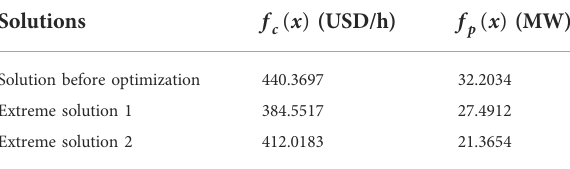
TABLE 8 Comparison of extreme solutions and the solution before optimization.